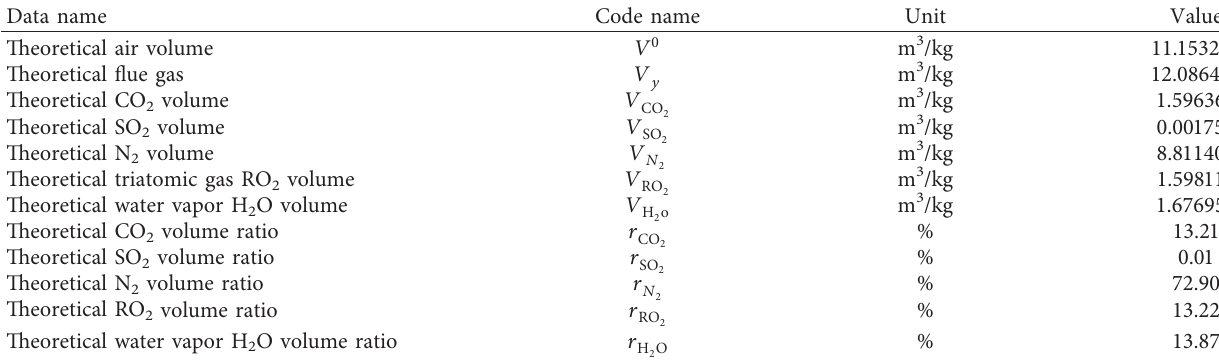
Table 1: Summary table of smoke